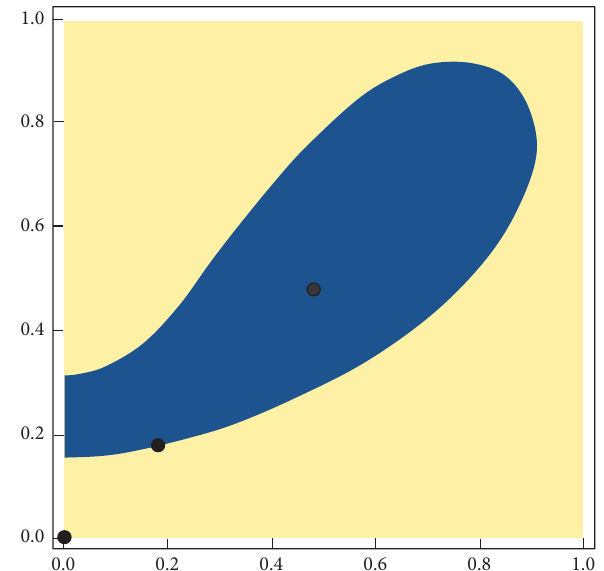
Figure 1: Basins of attraction for equation (1) for parameters a � 0 . 49 and f � 10 . 125. Picture is produced by Dynamica